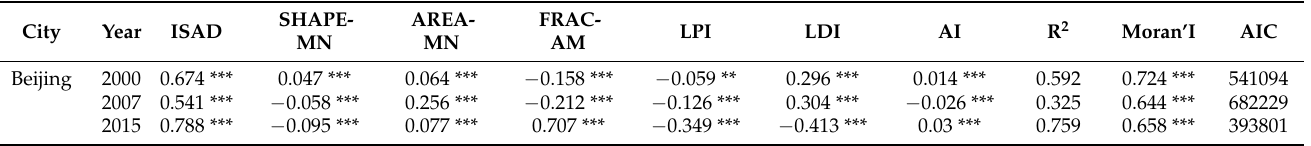
Table A2. The modeling results by the OLS model for the LST, the ISAD and the ISA landscape configuration metrics within different cities considered in this study from 2000 to 2015. * indicates p < 0.05; ** indicates p < 0.01; *** indicates p <